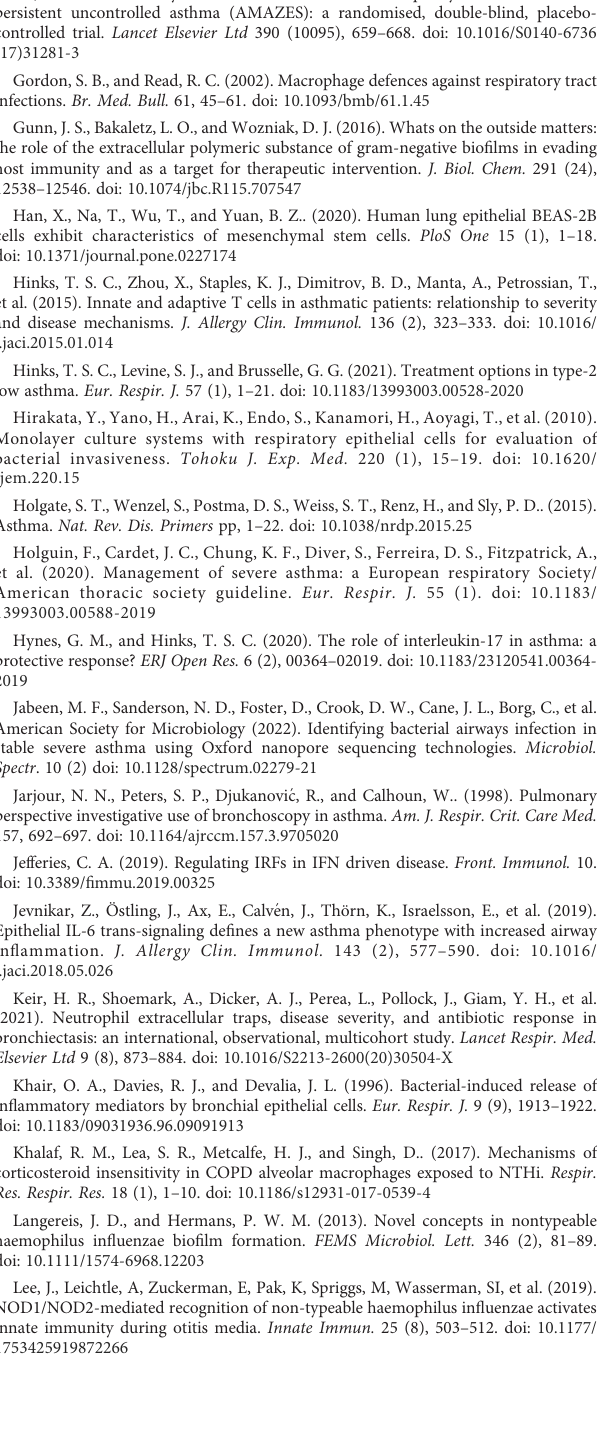
SUPPLEMENTARY TABLE 9 qPCR primer list Table listing qPCR primer sequences used in this manuscript, with the exception of proprietary Fluidigm PCR array